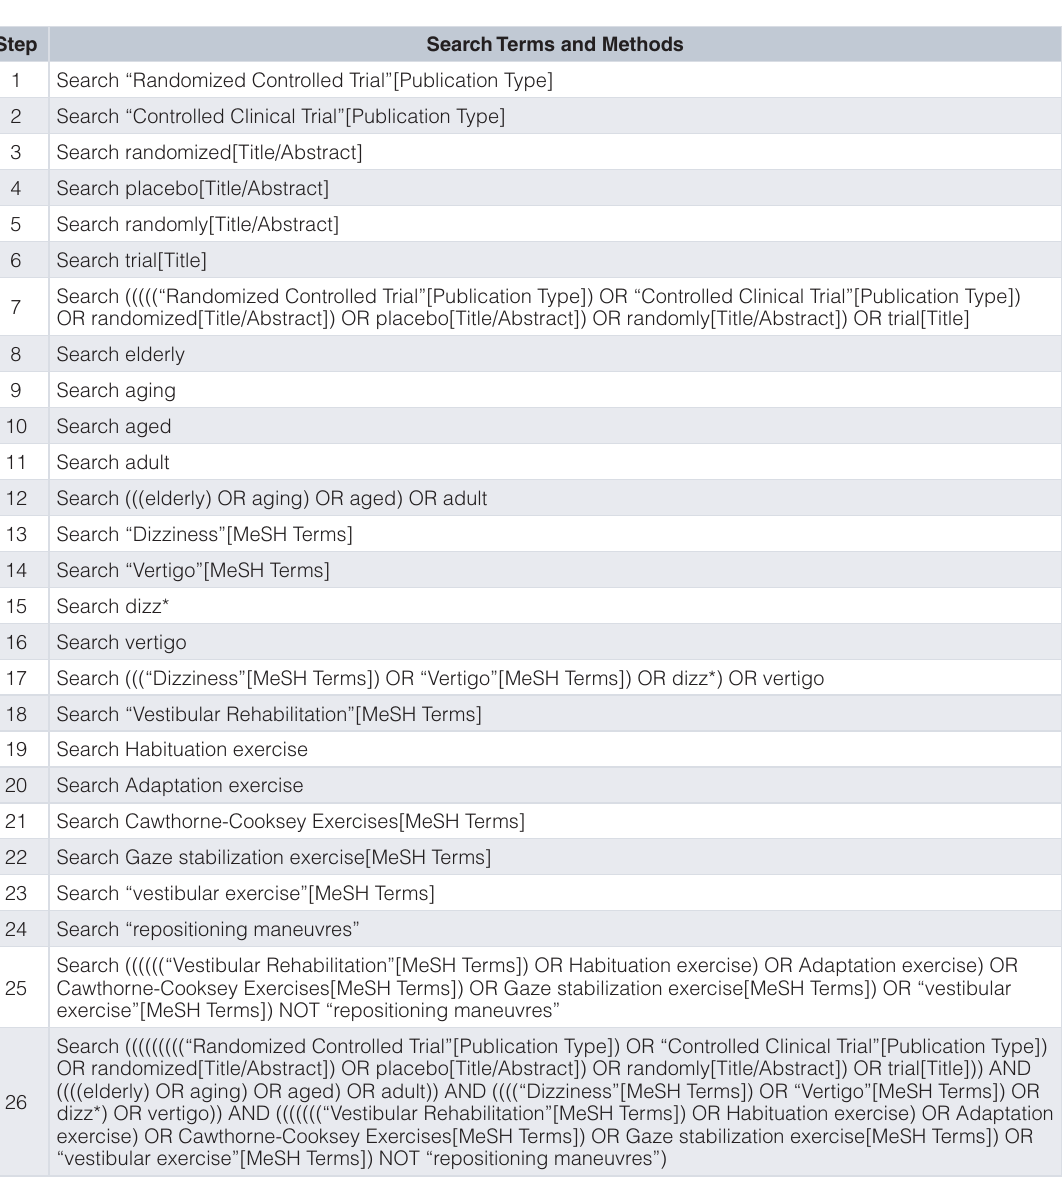
Table 1. Search Strategy for